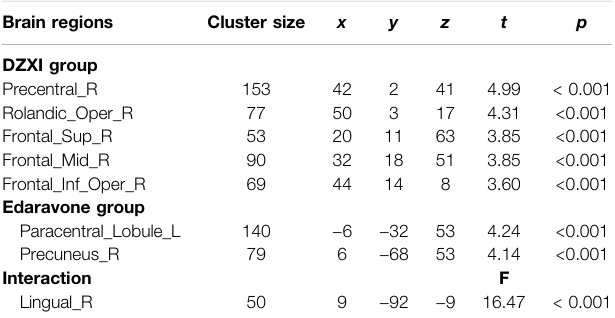
TABLE 2 | The brain regions of grey matter signi fi cantly alternated by the drugs treatments in AIS